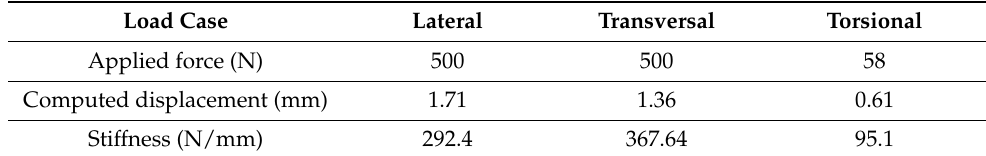
Figure 16. Numerical simulation of hood “A”: ( a ) boundary conditions for longitudinal loading case; ( b ) displacements— longitudinal; ( c ) displacements—transversal; ( d ) displacements—torsional. Table 8. Computed displacements and stiffnesses of the composite hood “A”.